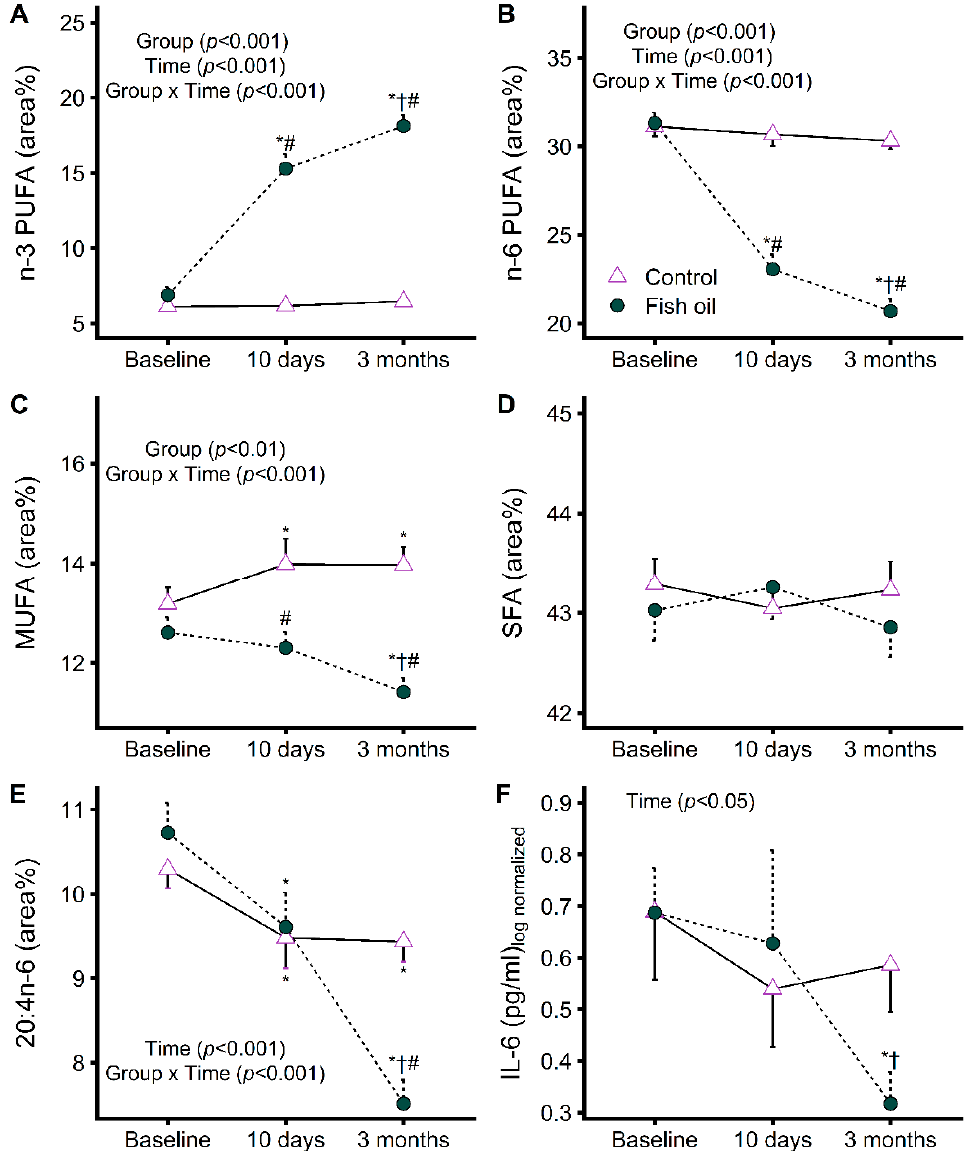
Figure 5. Plasma levels of n-3 ( A ) and n-6 ( B ) polyunsaturated fatty acid(s) (PUFA), monounsaturated fatty acid(s) (MUFA) ( C ), saturated fatty acid(s) (SFA) ( D ), 20:4n-6 ( E ), and interleukin-6 (IL-6) ( F ) in advanced breast cancer patients who complied with fish oil supplementation ( n = 14) or with a control supplementation ( n = 17) throughout the trial. * Significant difference with baseline values ( p < 0.05). † Significant difference with values at 10 days ( p < 0.05). # Significant difference with control ( p < 0.05).